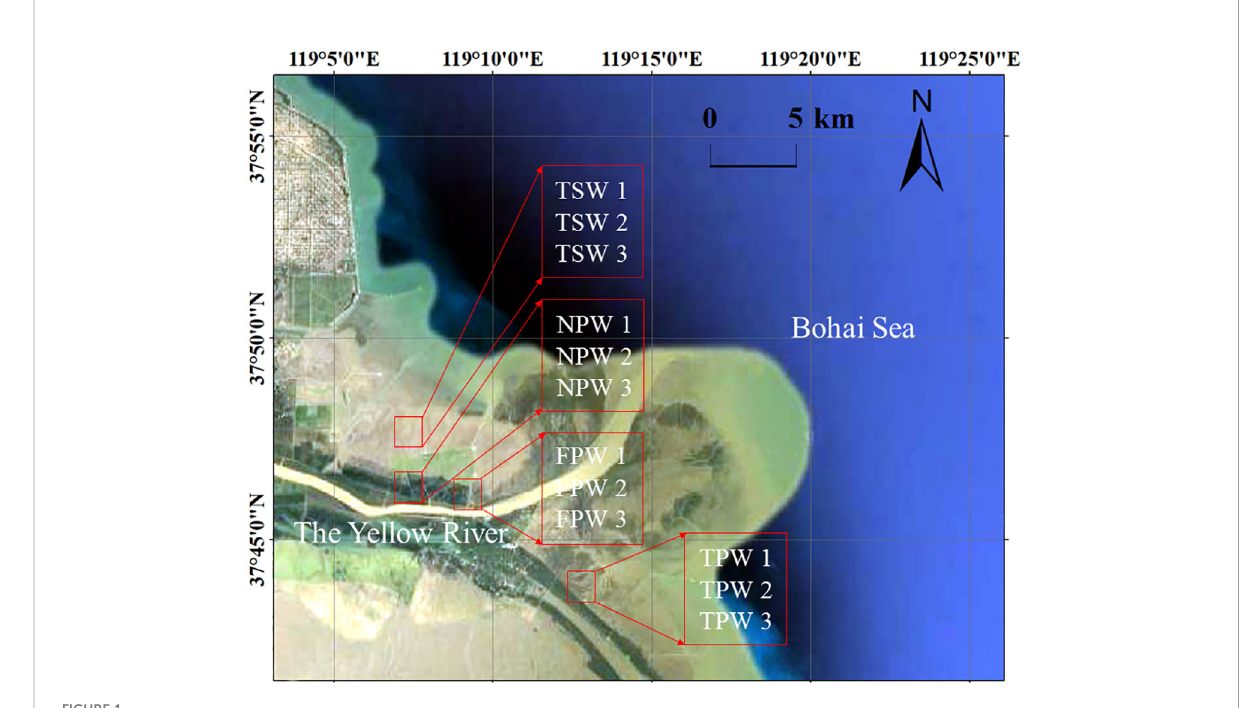
FIGURE 1 Location map of sampling